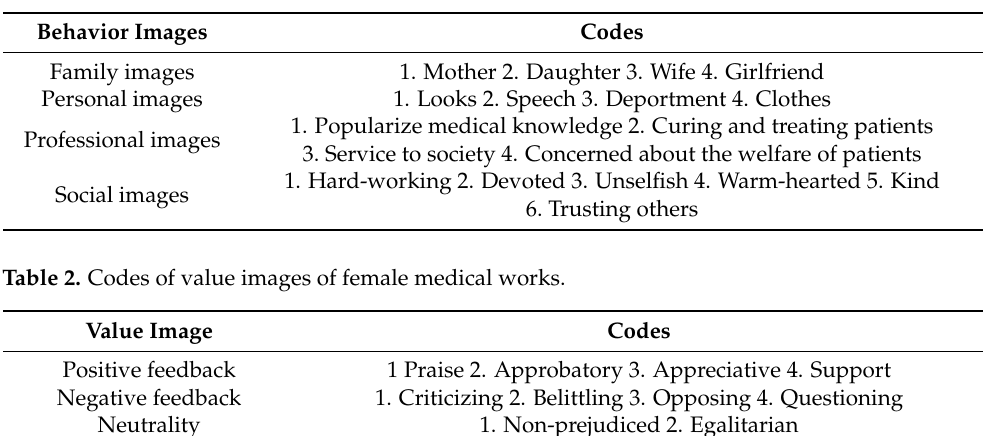
Table 1. Codes of behavior images of female medical works.